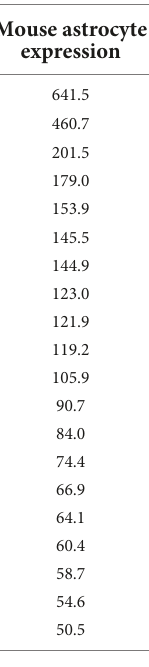
TABLE 2 Human-astrocyte specific genes identified in ferret astrocytes (Zhang et al., 2016). Genes in human and ferret astrocytes not found in mouse astrocytes Gene symbol Ferret astrocyte expression Mouse astrocyte expression Calcoco2 157.1